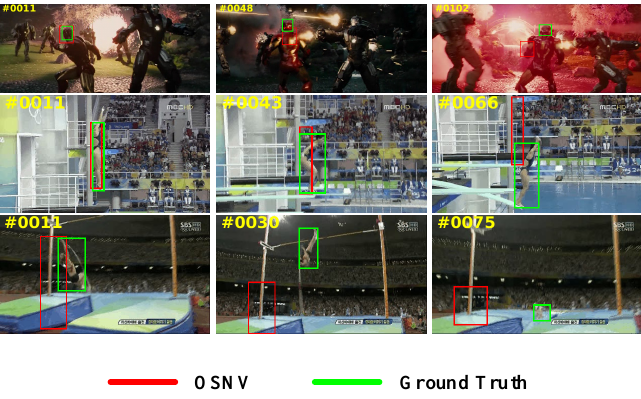
Figure 11. Failure cases of OSNV algorithm about three video sequences: Diving, Ironman, Jump, from top to